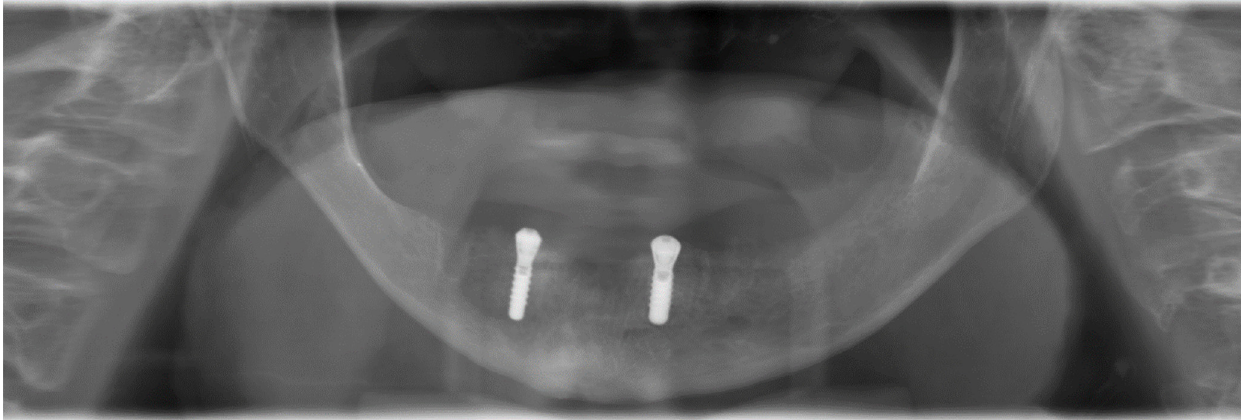
Figure 4. Postoperative panoramic view after the insertion of two interforaminal tissue-level implants.